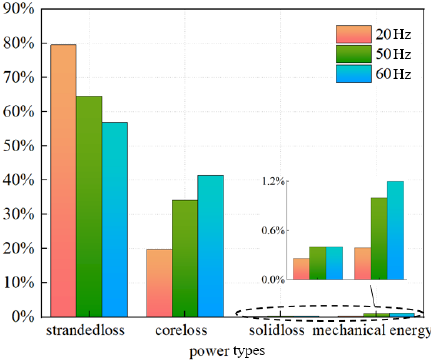
Figure 8. Power proportion in single voltage strategy.